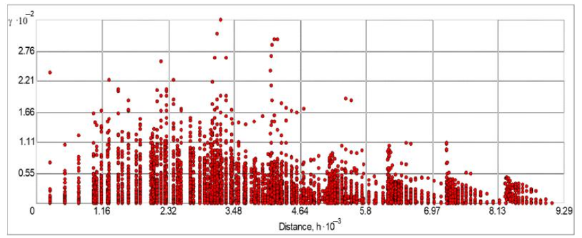
Figure 13. The semivariogram graph of the predicted points for average CO 2 variation with distance, obtained from the natural neighbor interpolated